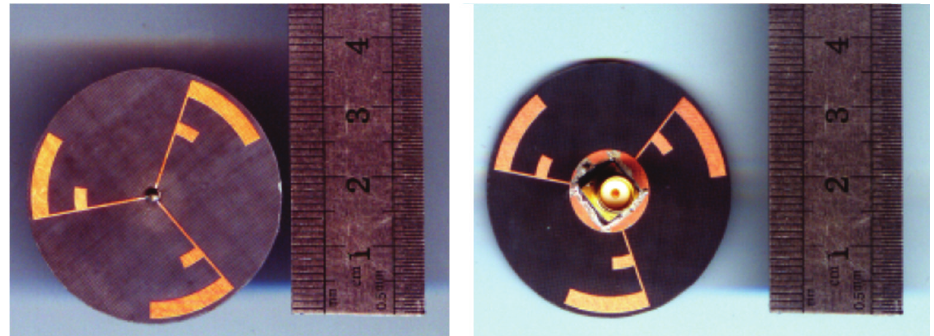
Figure 3: The fabricated UWB omnidirectional microwave antenna (top view and bottom view).